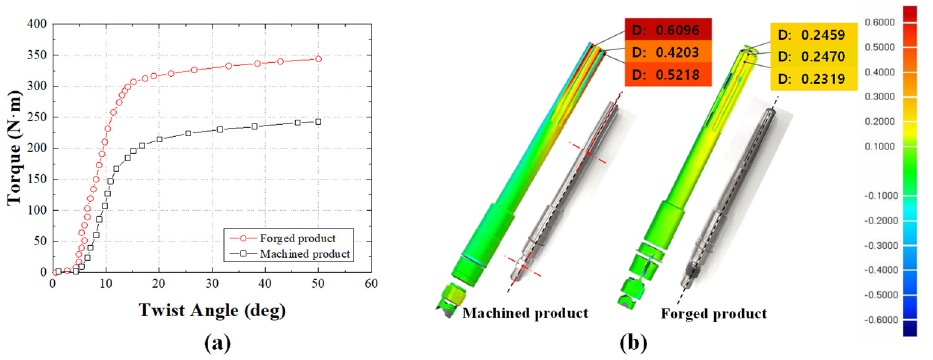
Figure 10. ( a ) Torque–angle curves for comparison of the machined and forged products from the torsion test and ( b ) results of the 3D scan obtained before and after the torsion test.